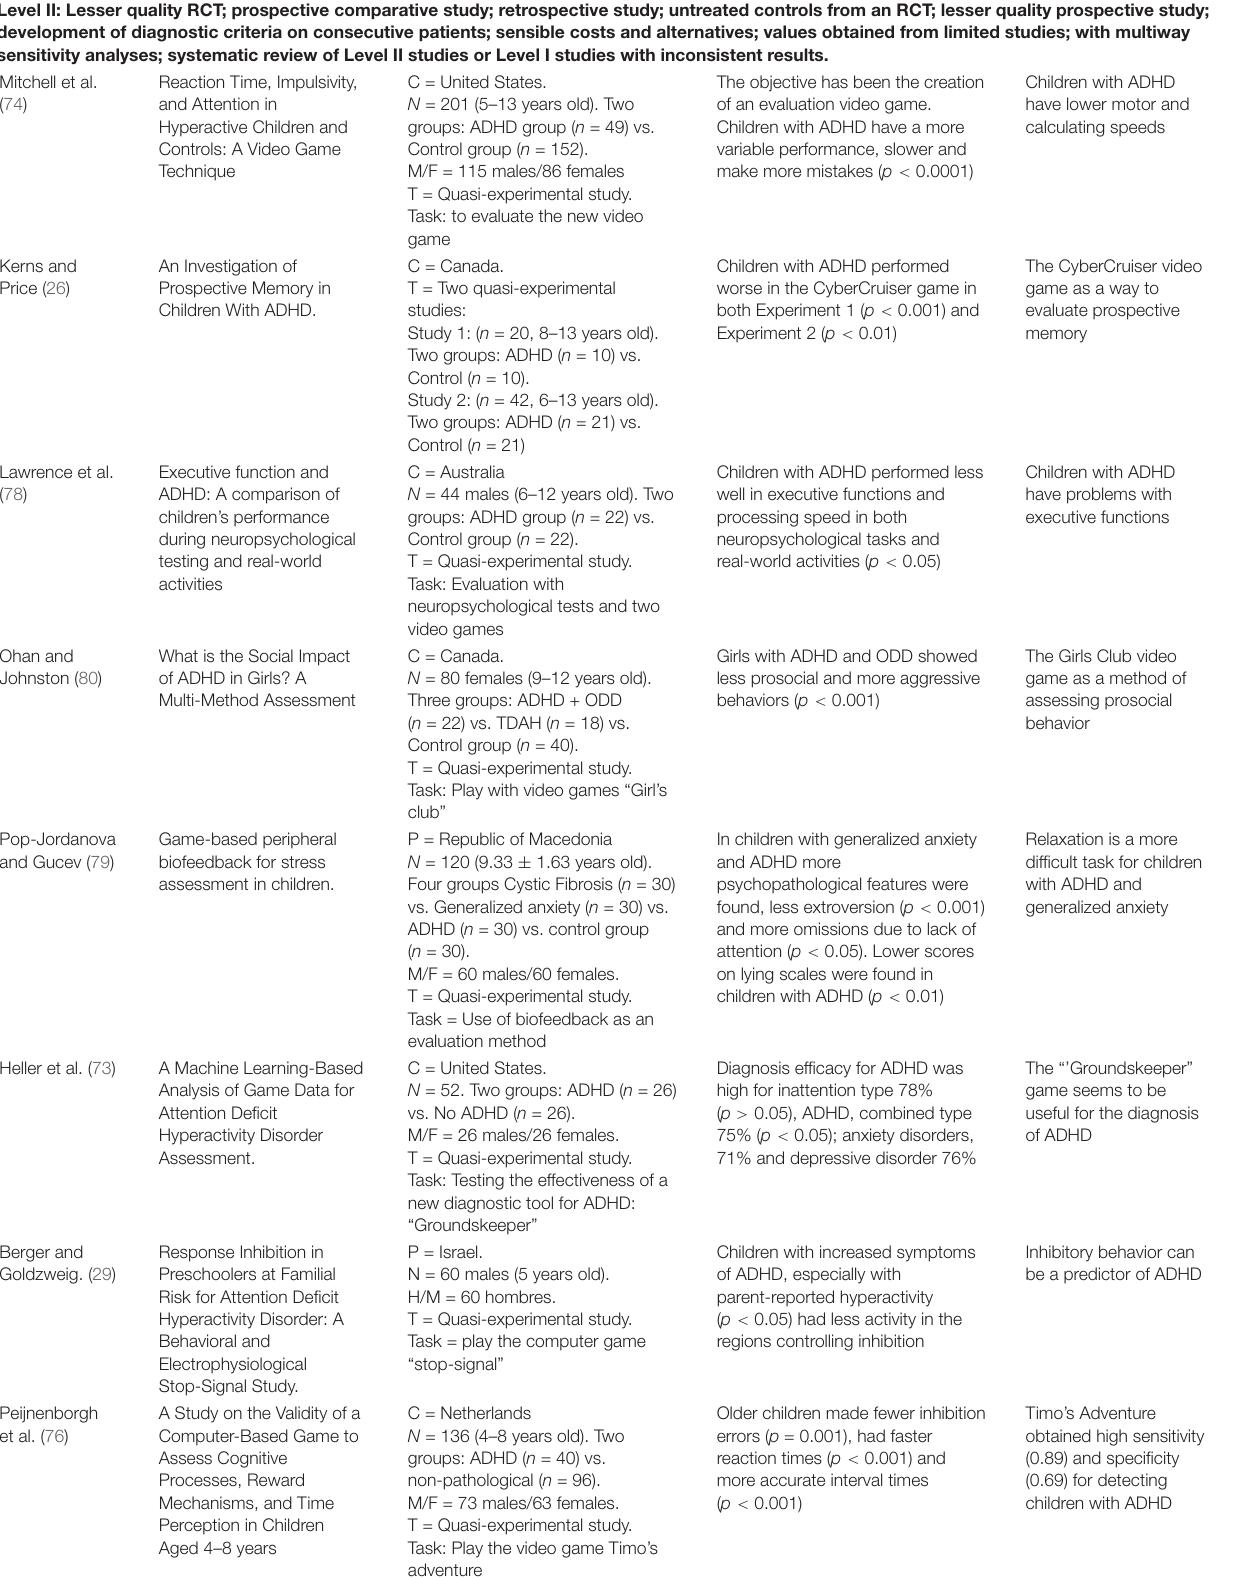
TABLE 2 | Serious video game for health as an assessment tool in ADHD patients. Level II: Lesser quality RCT; prospective comparative study; retrospective study; untreated controls from an RCT; lesser quality prospective study; development of diagnostic criteria on consecutive patients; sensible costs and alternatives; values obtained from limited studies; with multiway sensitivity analyses; systematic review of Level II studies or Level I studies with inconsistent